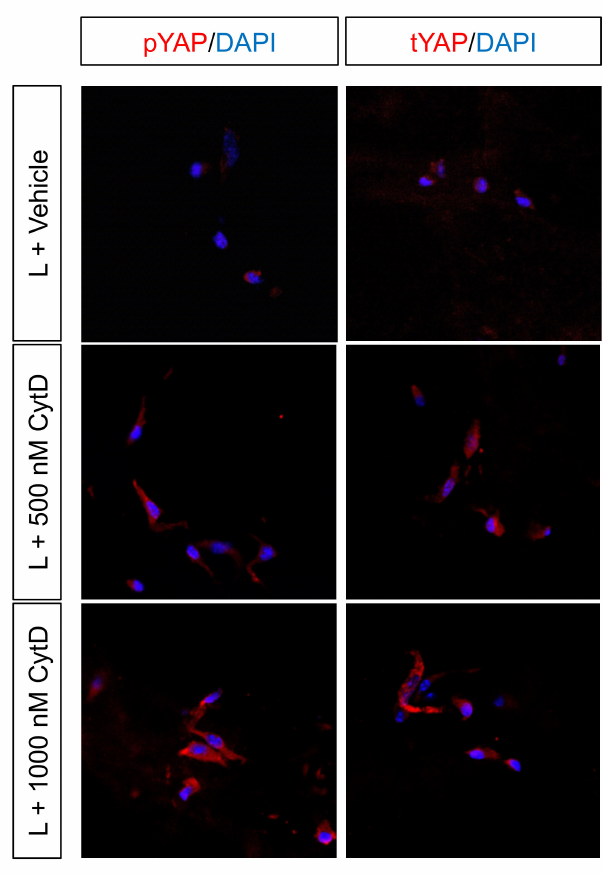
Figure 5. Immunofluorescence demonstrates the effect of CytD administration to increase YAP phosphorylation ( left ) and decrease nuclear YAP translocation ( right ) in a dose-dependent manner, consistent with the literature after 7 days culture and 24 h CytD